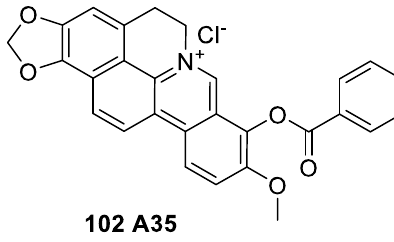
Figure 12. Structure of A35 .